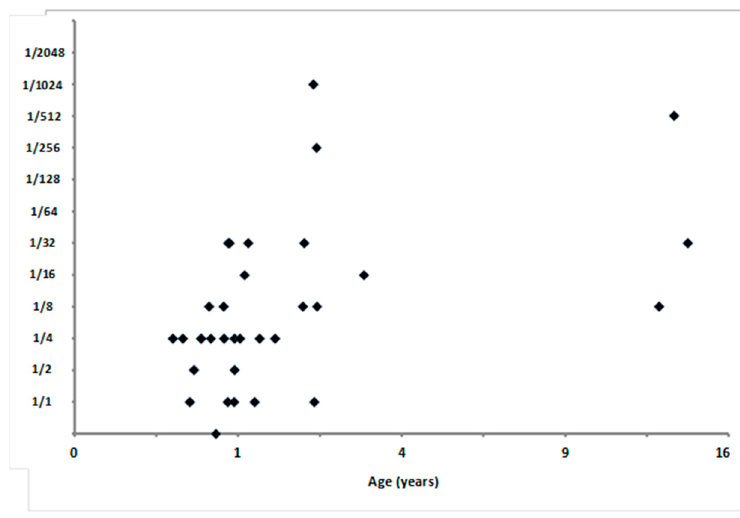
Figure 1. Correlations between pre-transplant anti-donor blood group antibodies (at pre-transplant workup) and the recipient’s age at the time of living donor liver transplantation performed in a series of 34 ABO-incompatible pediatric recipients between February 2005 and April 2019 at the Cliniques Universitaires St Luc in Brussels, Belgium. LT: liver transplantation.